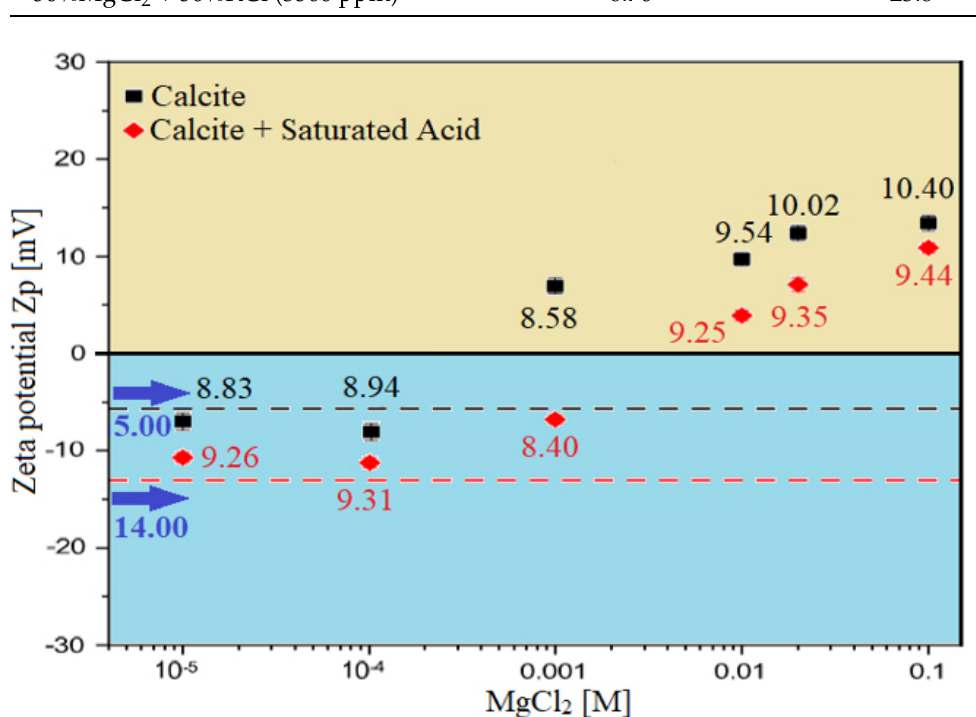
Figure 24. Zeta Potential (ZP) of calcite carbonate rocks/brine interface; It shows the effect of brine solutions containing divalent ions (MgCl 2 ) on the behaviour of surface charge alteration on calcite rock